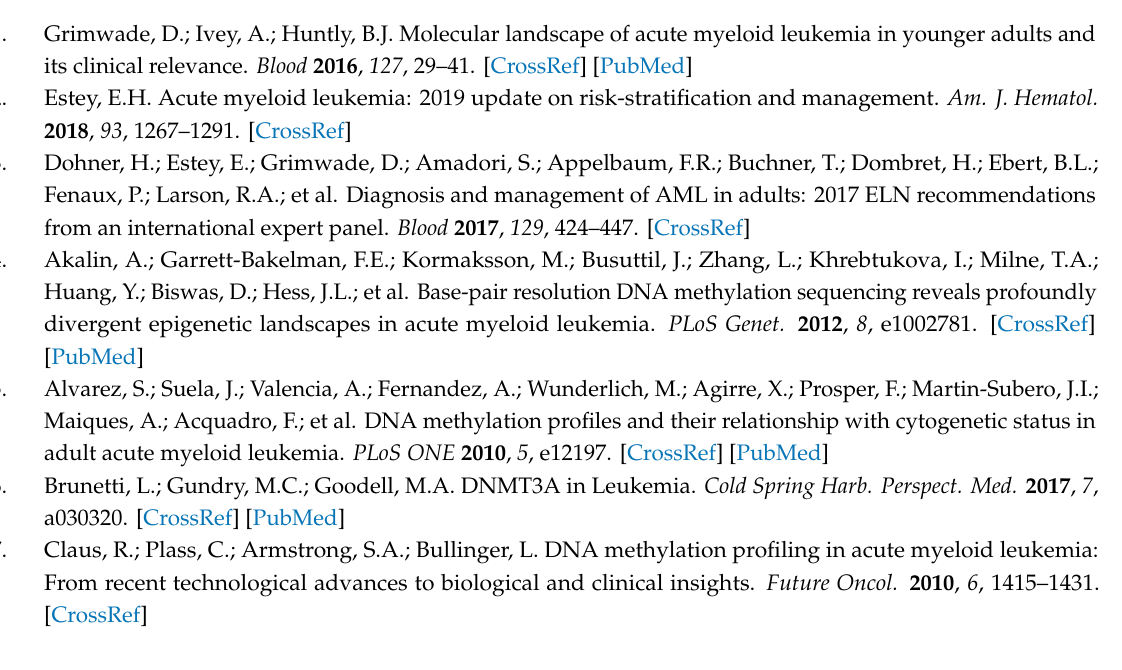
Figure S1: The bootstrap mean Dunn Index and bootstrap reproducibility of 793 methylation HCMs, Figure S2: A heatmap of cytogenetics and subgroup assignments of the nine candidate HCMs, Figure S3: The bootstrap mean Dunn Index and bootstrap reproducibility of expression HCMs, Figure S4: Subgroup assignments of the candidate expression HCMs, Table S1: Patient Characteristics, Table S2: Five hundred CpG sites that defined 7 methylation groups in an unsupervised bootstrap clustering analysis in AML patients, Table S3: Seven hundred probes that defined 7 expression groups in an unsupervised bootstrap clustering analysis in AML patients, Table S4: Paired Table S5: Top 100 Methylation signatures di ff erentiating FLT3-ITD with noj FLT3-ITD